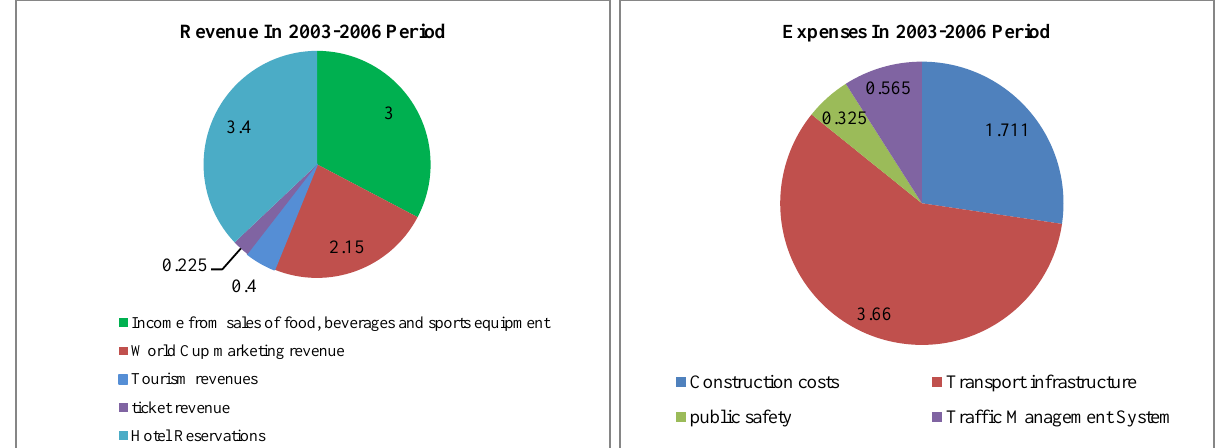
Figure 2. Germany's revenues and expenses to host the World Cup ($ 1 billion).